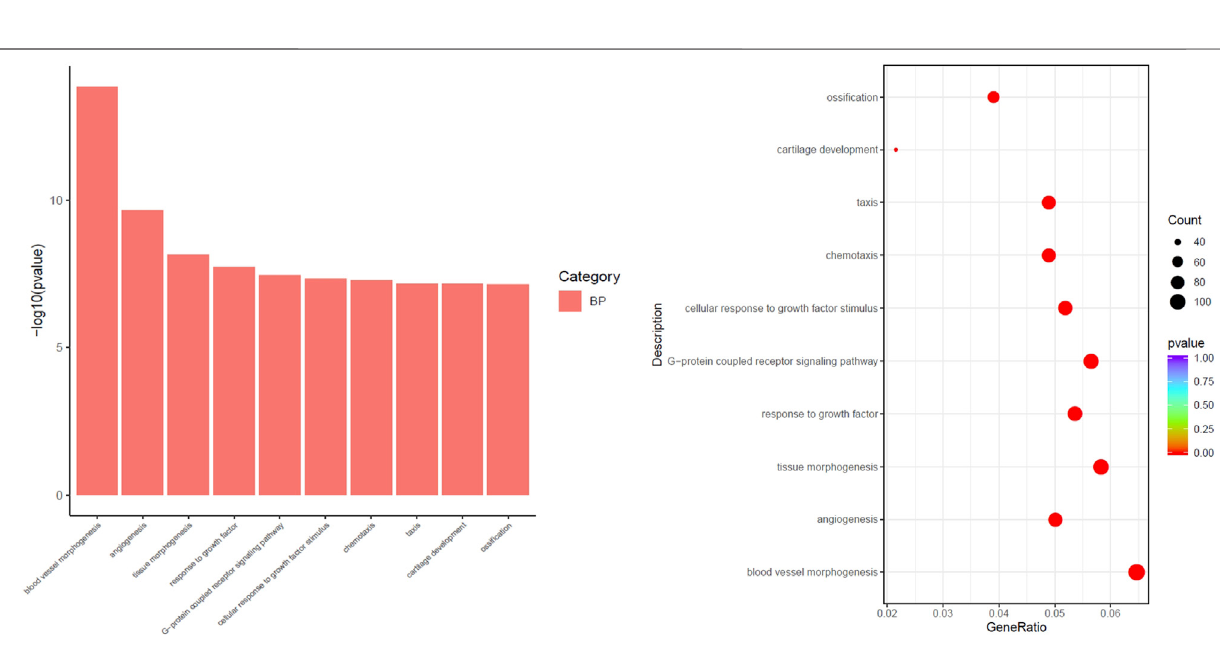
Frontiers in Pharmacology |